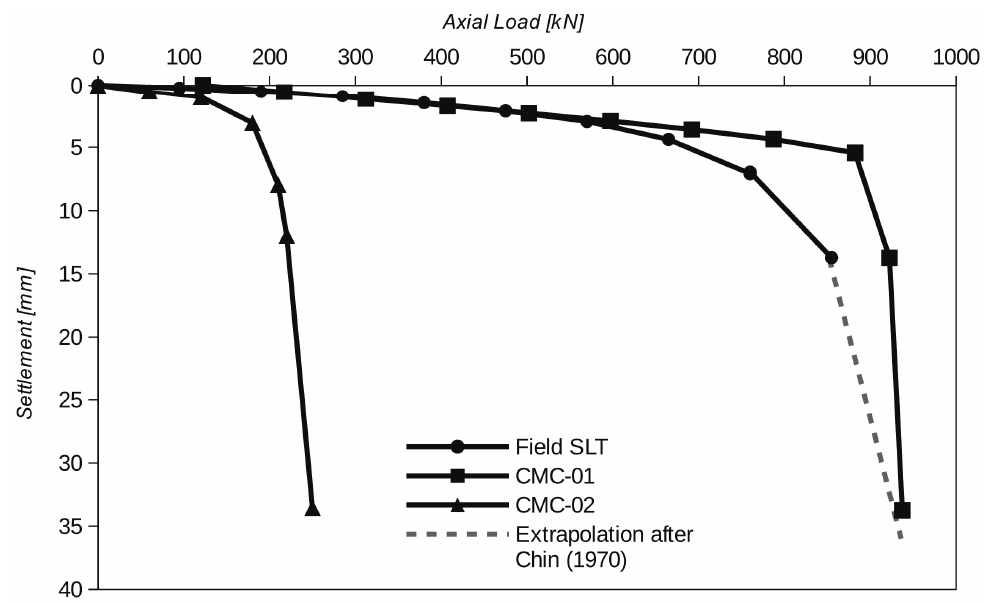
Fig. 12. Field Static load test versus numerical ones (CMC-1: “set-up” pile; CMC-2: “wish-in-place” pile)